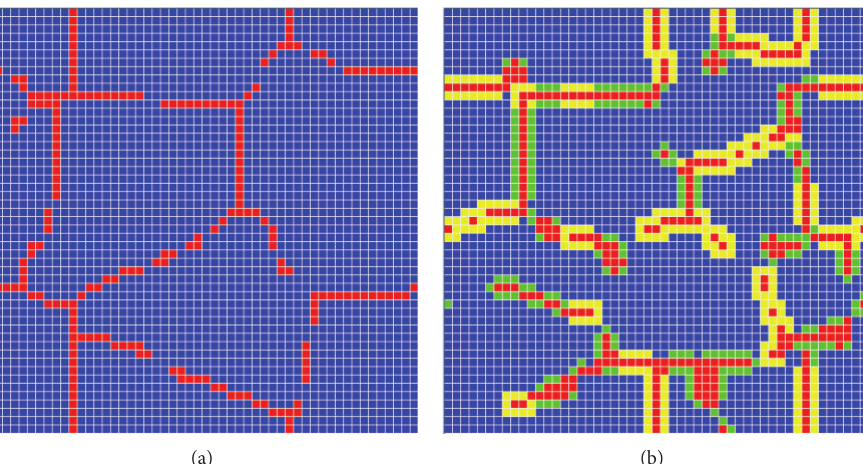
Figure 10: Simulation results on a 50 × 50 square lattice with Moore neighborhood and self-playing. The initial distribution of cooperators and defectors is randomly generated. The pattern in (a) is performed by the parameters region 𝑢 1 0 > 𝑢 3 1 , 𝑢 𝑖 0 < 𝑢 𝑖+2 1 (𝑖 = 2, 3, . . . , 6) , and the pattern in (b) is by the region 𝑢 6 0 > 𝑢 8 1 , 𝑢 𝑖 0 < 𝑢 𝑖+2 1 (𝑖 = 1, 2, . . . , 5) .